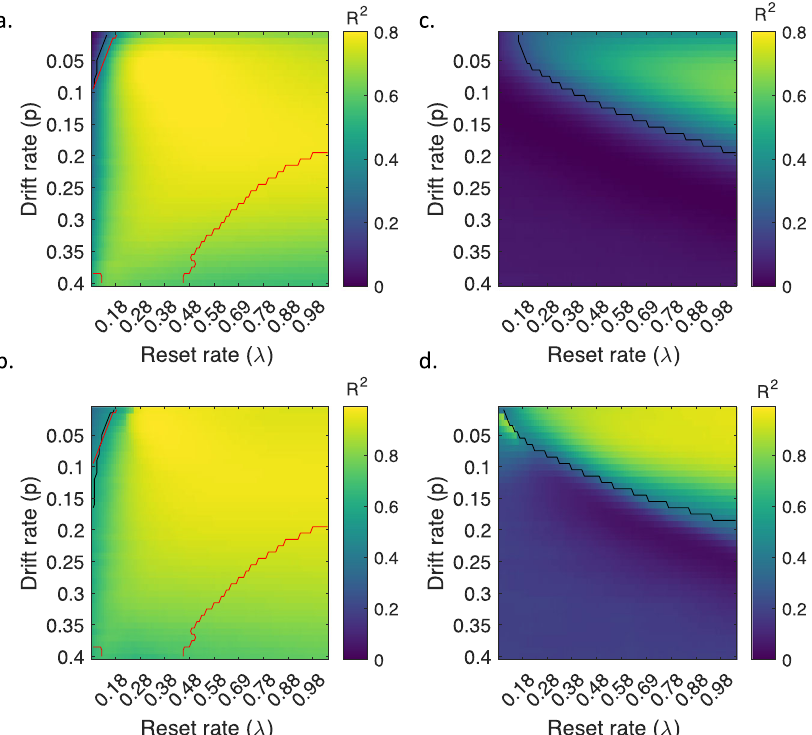
Fig. 6 Correlation between model outputs and the behavioural results under different parameter values. a Explained variance (R 2 ) of the behavioural results by the model outputs, fi tted with a generalized linear model. b Explained variance (R 2 ) of the behavioural results by the model outputs, fi tted with a generalized linear mixed model. In a , b , the fi rst contextual signal was used as the reference point for recency judgments. c , d are identical to a , b , except that the last contextual signal was used as the reference point for recency judgments. The black line in images indicates the signi fi cance threshold of p = 0.05, and the red line indicates the parameter values that yield model outputs which can recover all the effects in the four behavioural experiments. Source data are provided as a Source Data fi